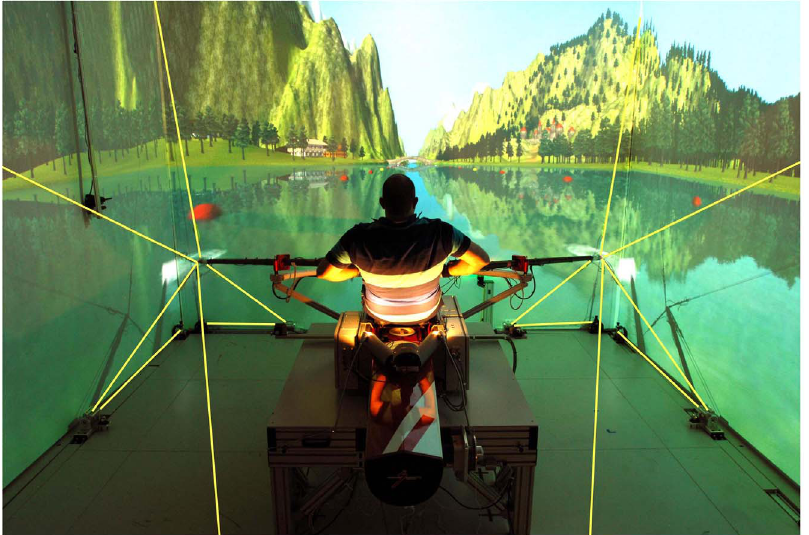
Figure 1. Training in the scull rowing simulator of the SMS-Lab at ETH Zurich. This scull rowing simulator is set up in a CAVE comprising auditory-, visual-, and haptic displays.